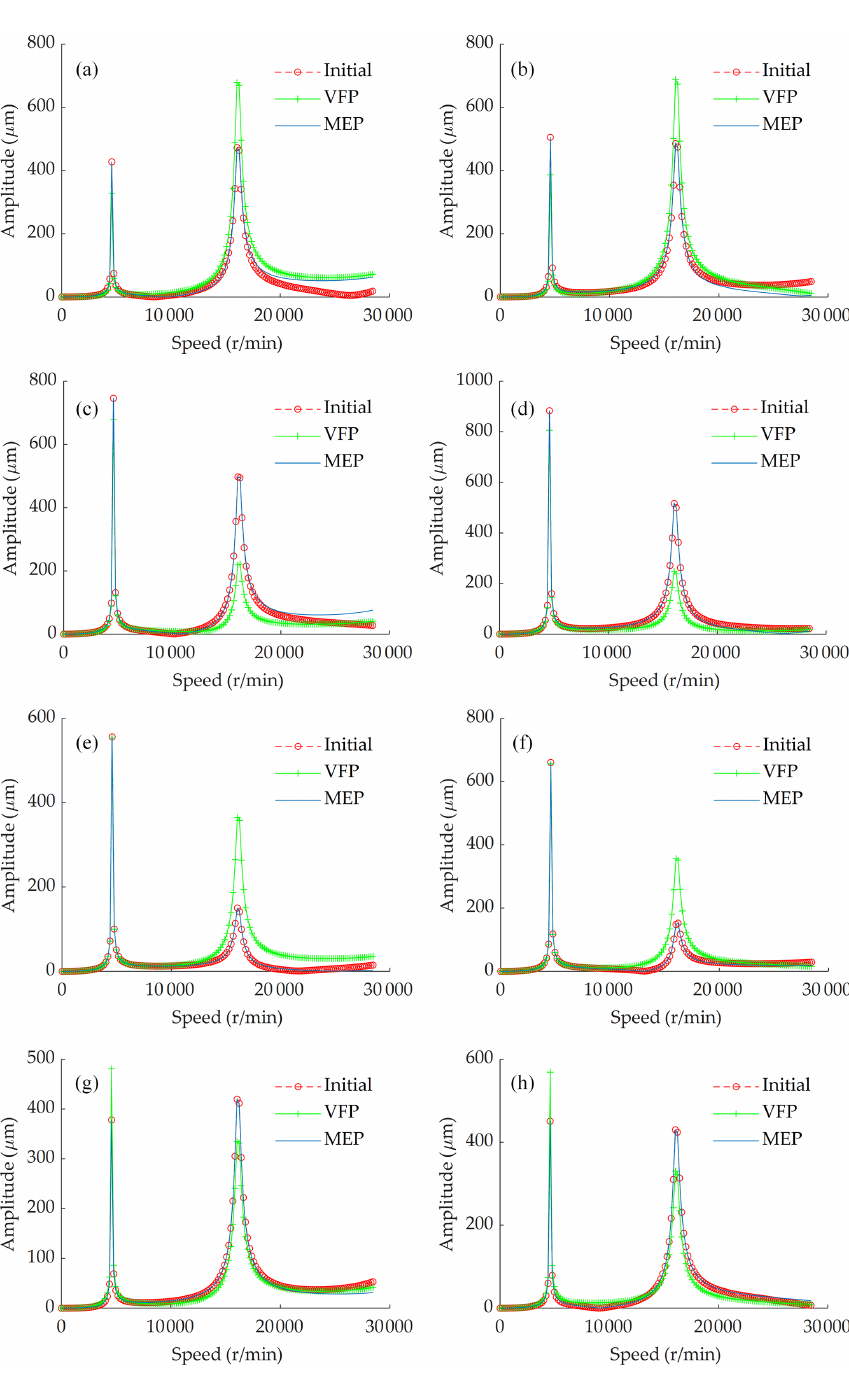
Figure 4. Comparison of unbalance response after equivalence of disks based on the VFP and MEP. (a) Left-hand side on the first disk. (b) Right-hand side on the first disk. (c) Left-hand side on the second disk. (d) Right-hand side on the second disk. (e) Left-hand side on the fourth disk. (f) Right-hand side on the fourth disk. (g) Left-hand side on the sixth disk. (h) Right-hand side on the sixth